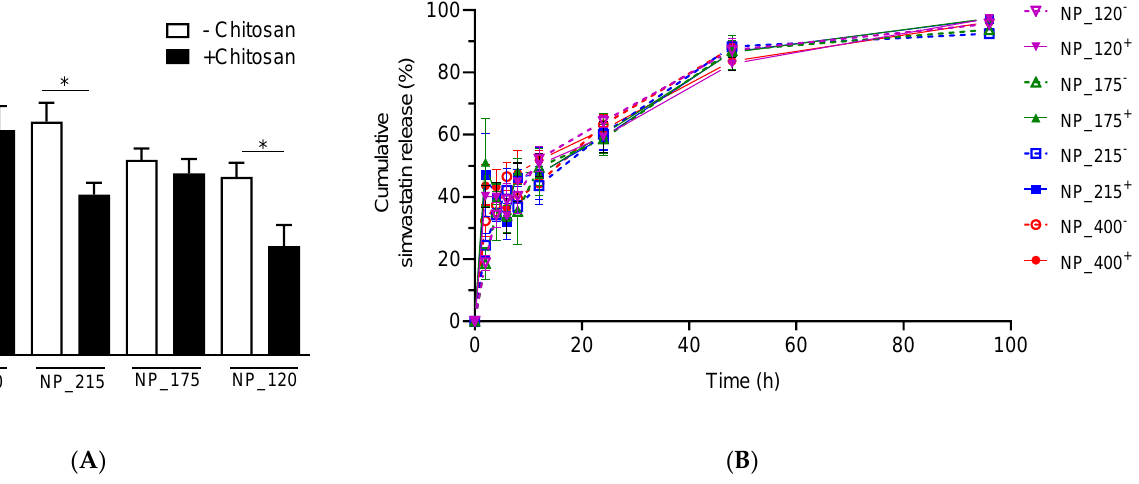
Figure 3. Simvastatin encapsulation and release. ( A ) Actual drug loading of eight NP formulations. ( B ) Cumulative release of simvastatin from each nanoformulation, as indicated. For all datasets, values are means ± SD, n = 4 separately prepared lots. One-way ANOVA followed by Tukey’s multiple comparisons test was performed. * p < 0.05 between indicated groups.